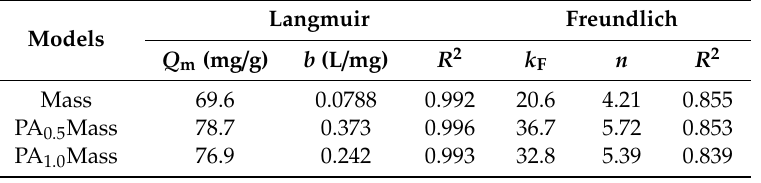
Table 1. Fitting results of the sorption data with the Langmuir and the Freundlich models.